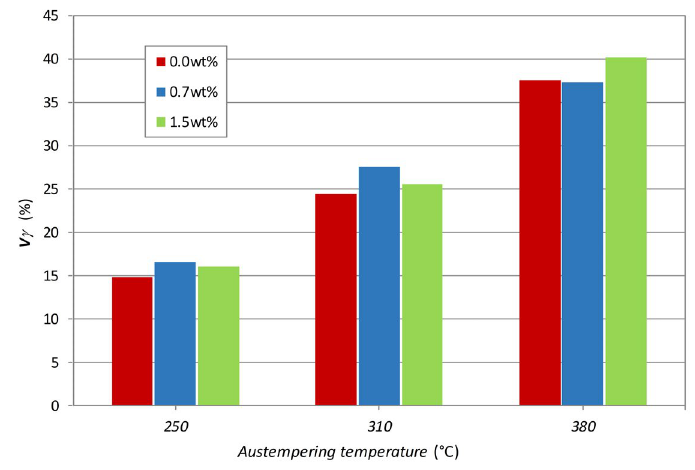
Figure 10. Average austenite volume fraction V γ vs. austempering temperature (250 °C for 6 h, 310 °C for 3 h and 380 °C for 1 h).